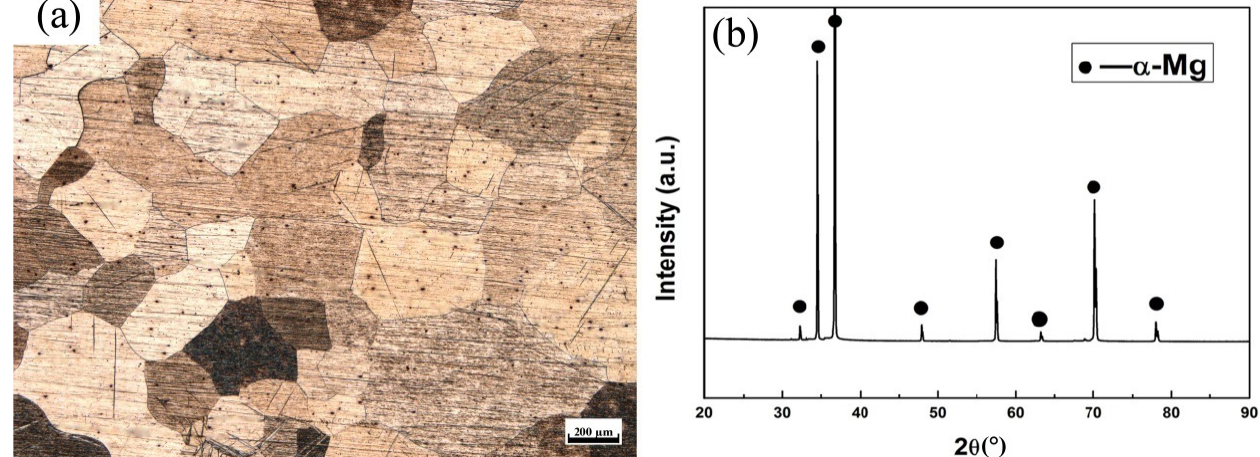
Figure 1. ( a ) The microstructure and ( b ) XRD patterns of the LA11 alloy.